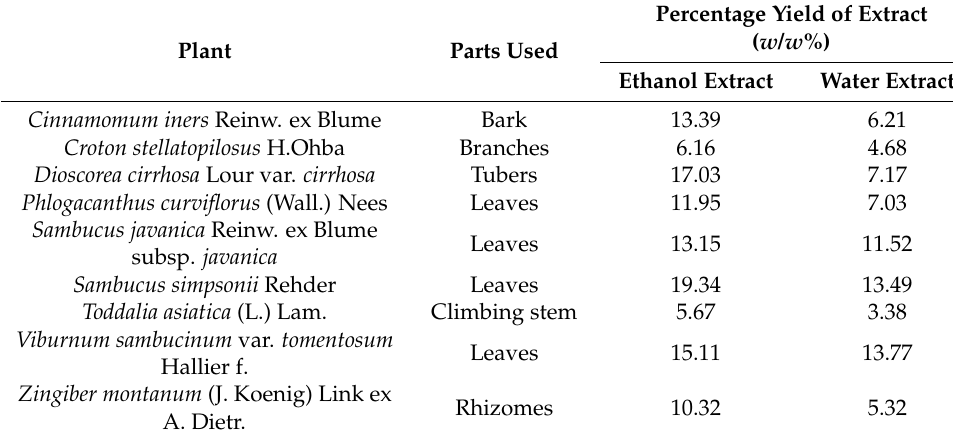
Table 3. Percentage yield of plant extracts in different solvents.